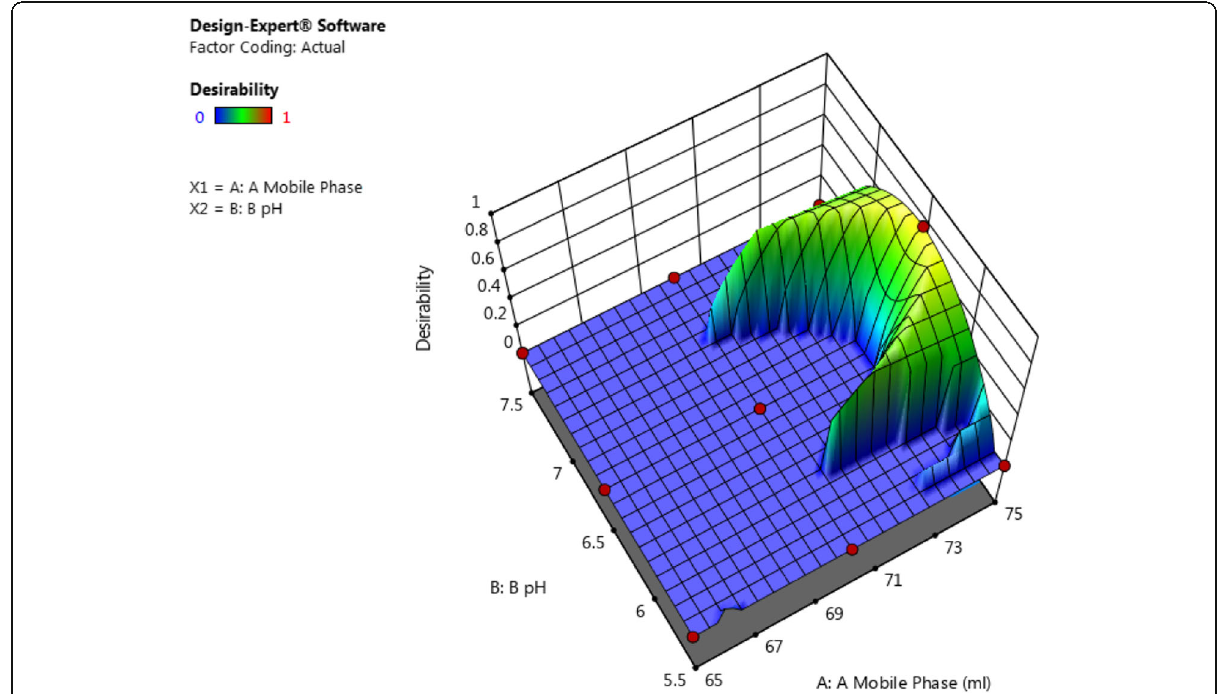
Fig. 4 3D surface plot of desirability for obtaining optimized